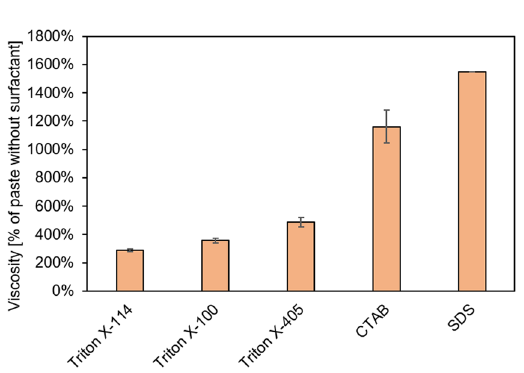
Figure 6. Viscosity of geopolymer pastes containing 1.9 × 10 − 6 mol/g of different surfactants. The results are expressed as a % of the reference paste (without